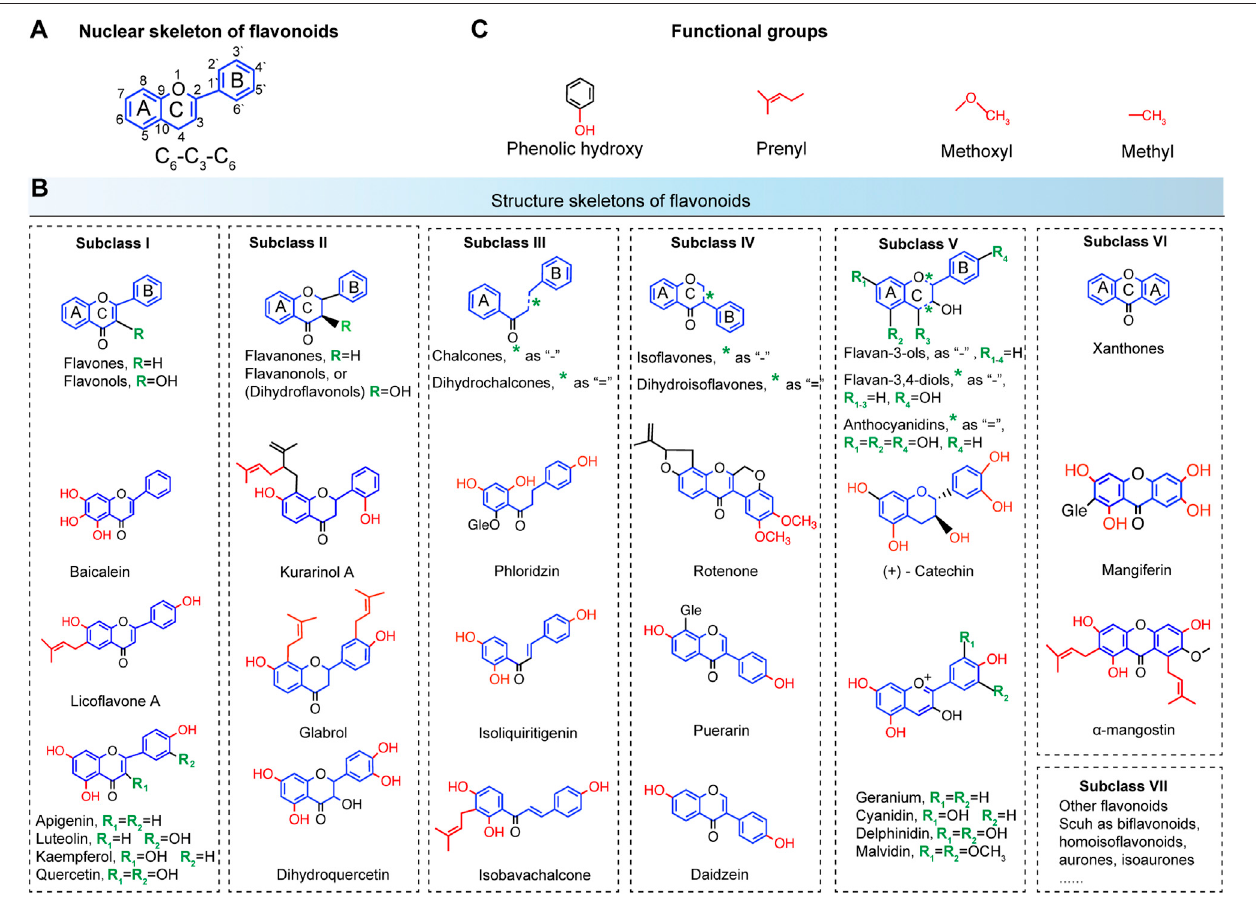
FIGURE 3 | Chemical structure classi fi cations of fl avonoids. (A) The nuclear skeleton of fl avonoids contains a 2-phenyl-chromone core with the C 6 -C 3 -C 6 system. The A and B benzene rings connect to each other through the central three carbon atoms, which can or cannot form the C ring. (B) The major subclasses of fl avonoids. Subclass I, fl avones and fl avonols; Subclass II, fl avanones and fl avanonols; Subclass III, chalcones and dihydrochalcones; Subclass IV, iso fl avones and dihydroiso fl avones; Subclass V, fl avan-3-ols, fl avan-3.4-diols and anthocyanidins; Subclass VI, xathones and mangiferin; Subclass VII, other fl avonoids such